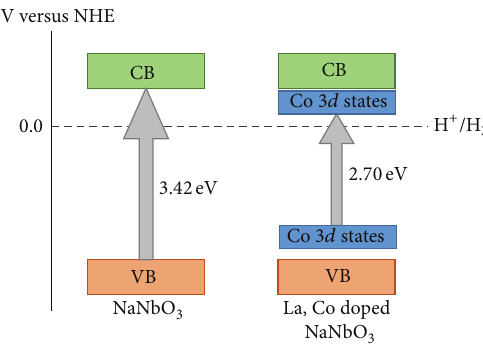
Figure 6: The schematic band structures of NaNbO 3 and La, Co codoped NaNbO 3